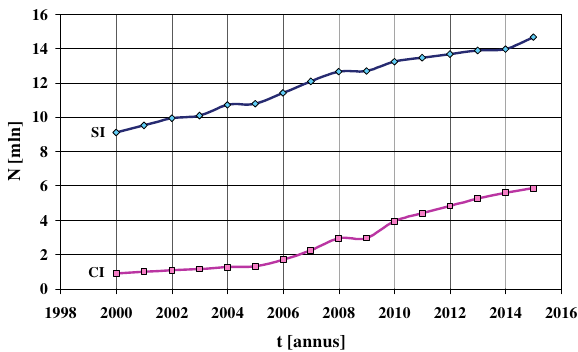
Fig. 1. Number of passenger cars with spark ignition- and compression ignition engines